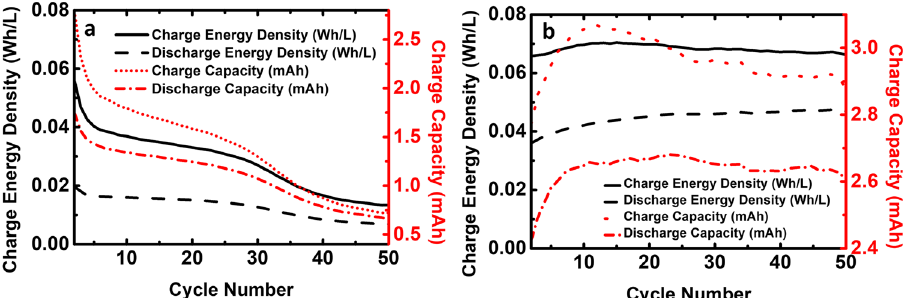
Fig. 6 Cell performance. Charge – discharge energy density and charge – discharge capacity plots of neutral pH aqueous organometallic and all-organic active materials for RFB single cells using 5.0 mM of TRYP-SO 3 H in 1.0 M KCl as supporting electrolyte. a 10.0 mM of K 4 [Fe(CN) 6 ]·3H 2 O as catholyte. b 5.0 mM of BQDS as catholyte.